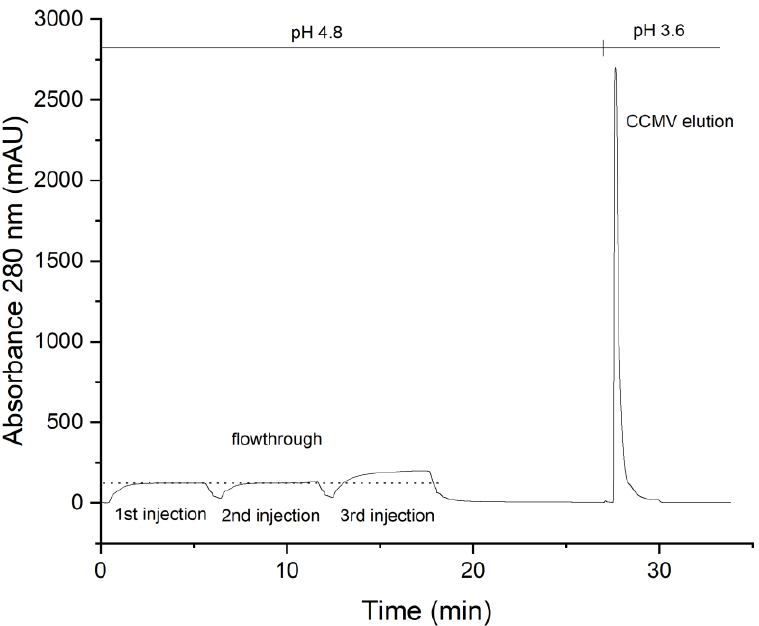
Figure 6. Column capacity for the binding of CCMV. Three 10 mL injections of a resuspended PEG-precipitate solution containing 0.1 mg/mL CCMV were made in succession. The flowthrough of the 1st and 2nd injections is free of any CCMV as determined with ELISA. It contains impurities from the plant matrix and PEG 8000. After the third injection, the column capacity is exceeded, and flowthrough peak is increased, as indicated by the dashed line. The column capacity was determined as approximately 2 mg of CCMV. After washing with binding buffer and elution at pH 3.6, pure CCMV was obtained as a narrow peak. The eluting CCMV is immediately neutralized to approximately 50 mM sodium acetate pH 4.8 with a small volume of concentrated neutralization buffer present in the fraction collector.